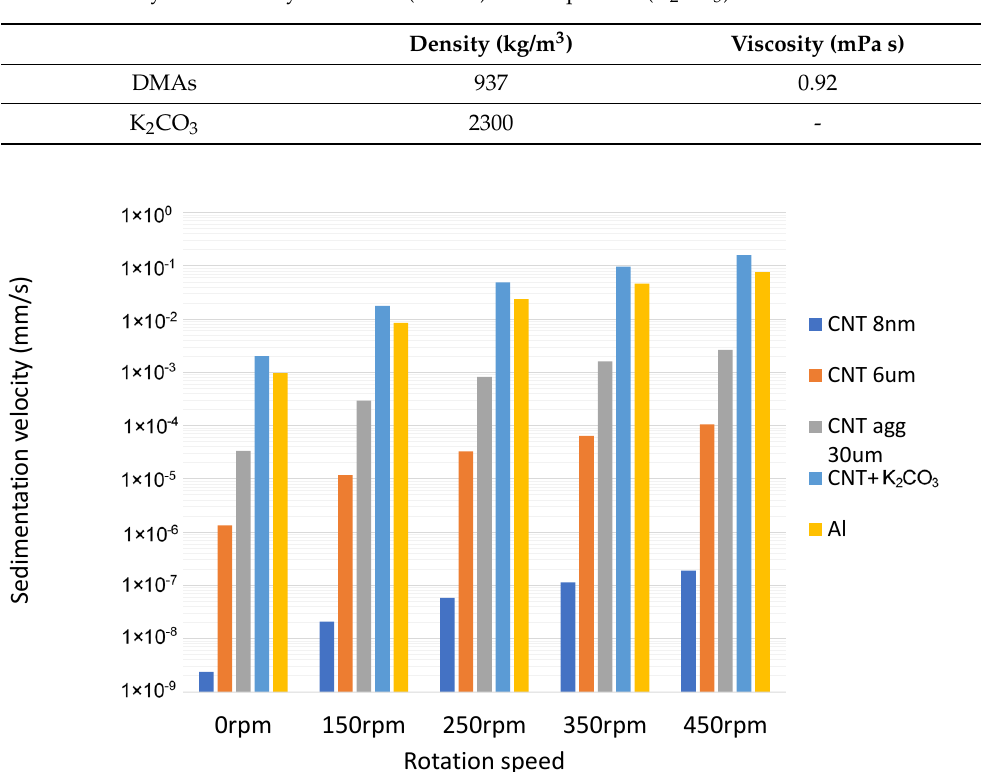
Table 3. Density and particle size of Al and CNT.